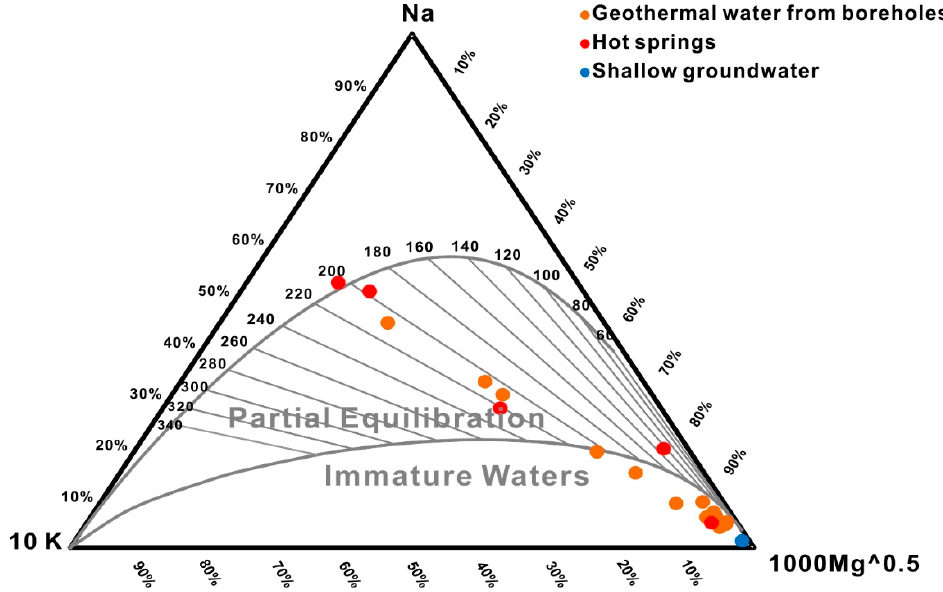
Figure 12. Giggenbach diagram for geothermal water samples [75].